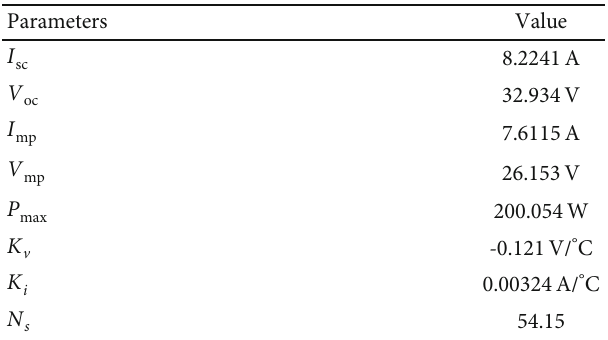
Table 1: Electrical speci fi cations considered for the PV module under STC.